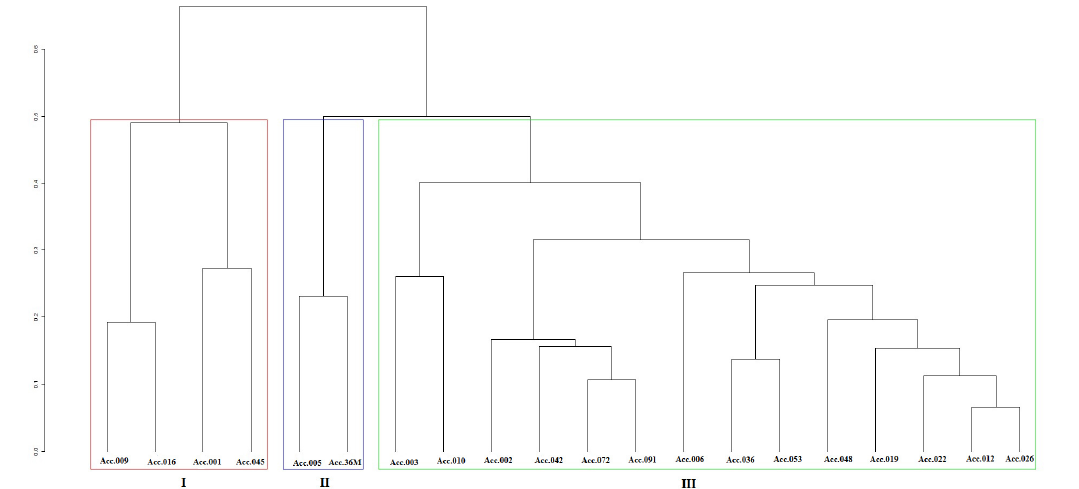
Fig. 2. Agglomerative cluster dendrogram constructed from morphological data of 20 Nigerian castor genotypes